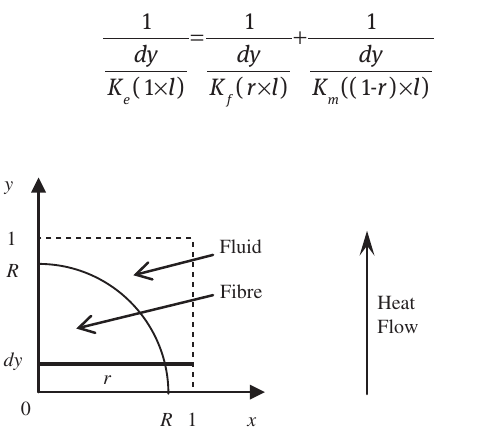
Figure 3 Heat flow in a quarter cross-section of quadratic fibre